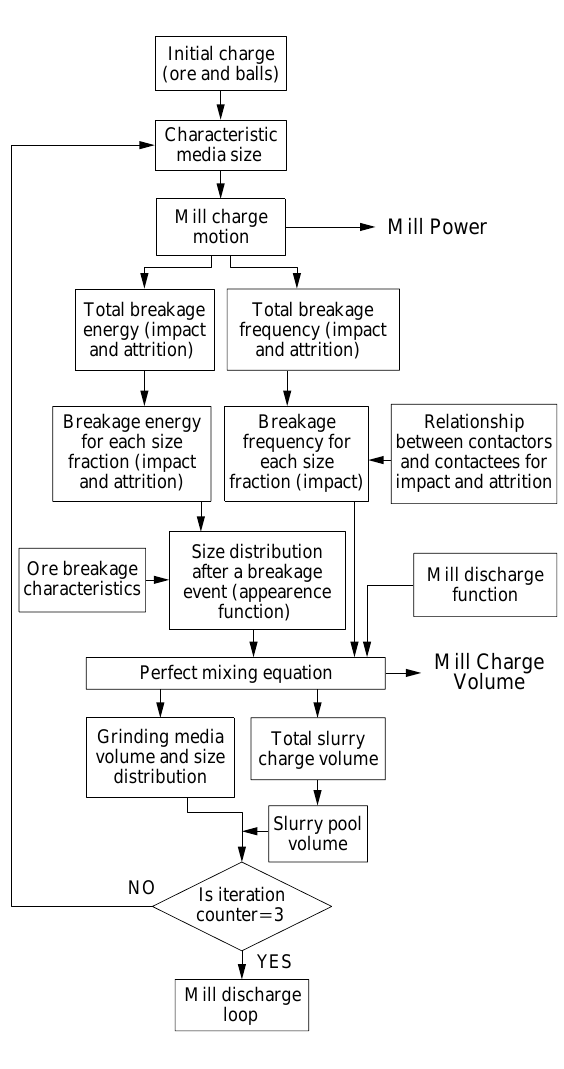
Grinding Charge